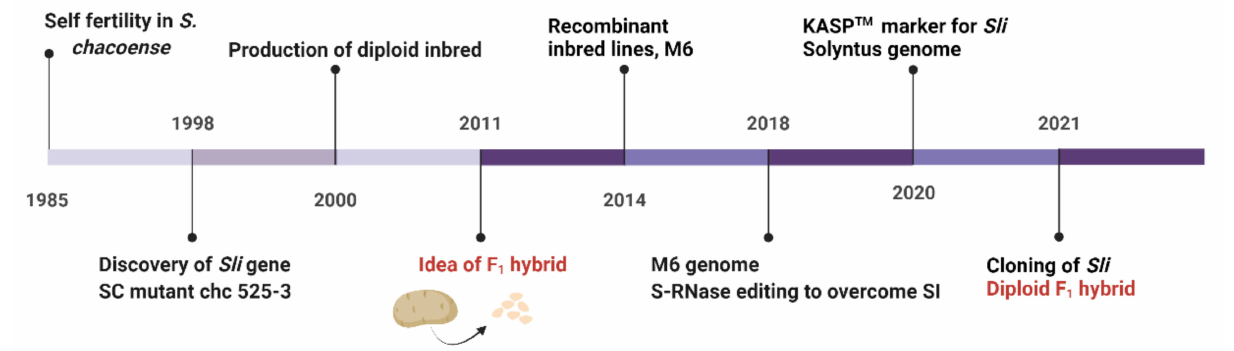
Figure 2. The major events in Sli gene discovery and development of F 1 hybrid in diploid potato. Major events before the idea of F 1 hybrid was conceived includes discovery of Sli gene in natural SC mutants of S. chacoense followed by development of inbred lines in diploid potatoes [1,53,61,62]. After that there have been major achievements like development of recombinant inbred lines, development of self compatible clone, M6 and S-RNase edited lines [2,36], sequencing of SC clones, M6 and Solyntus [32,63], development of DNA markers [30] and cloning Sli [33,34]. These important events contributed to the development of diploid F 1 hybrid in potato